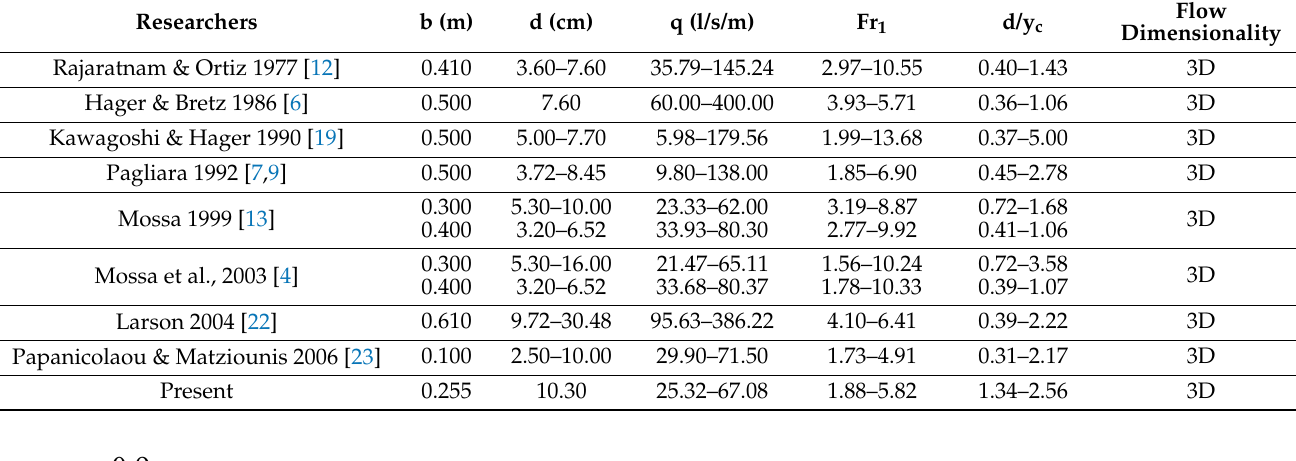
Table 4. Main geometric and hydraulic parameters of earlier and the present experiment.